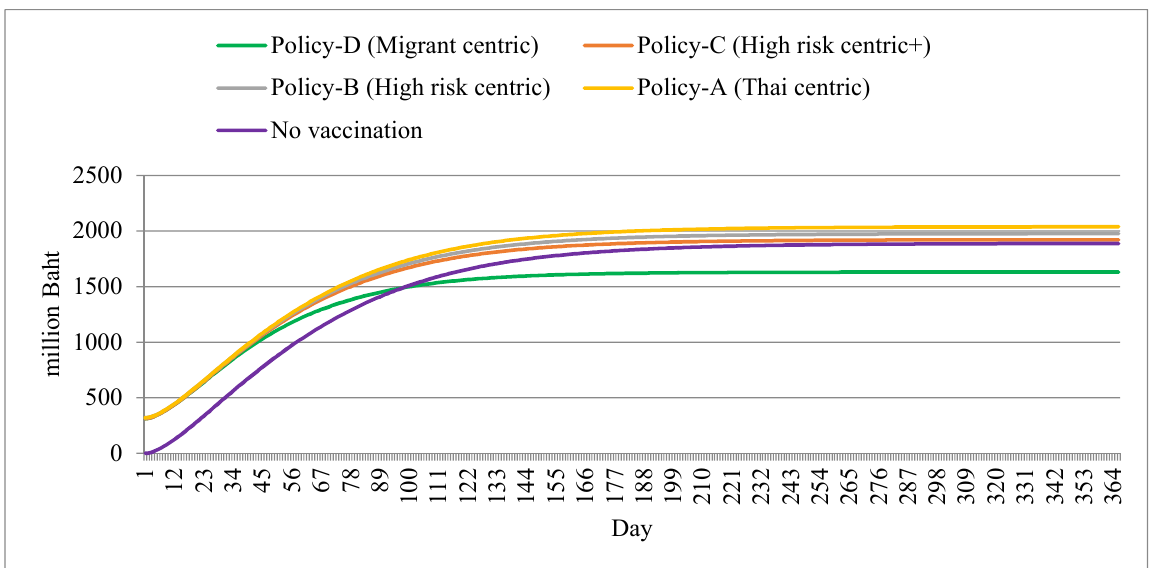
Figure 6. Total state-born cost by different policy scenarios.